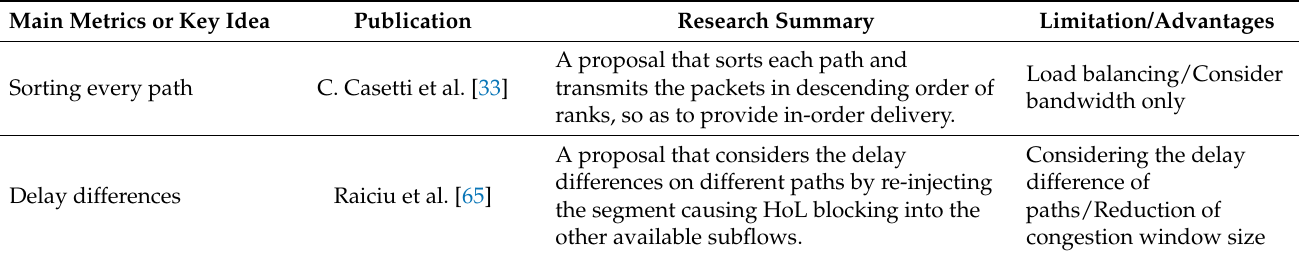
Table 3. Studies on the MPTCP